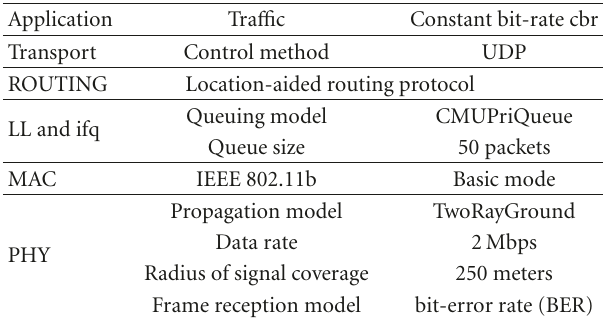
Table 1: The configuration parameters of an IEEE 802.11b wireless